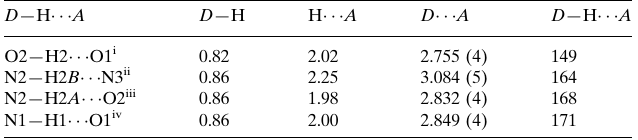
Hydrogen-bond geometry (A˚ , (cid:2)